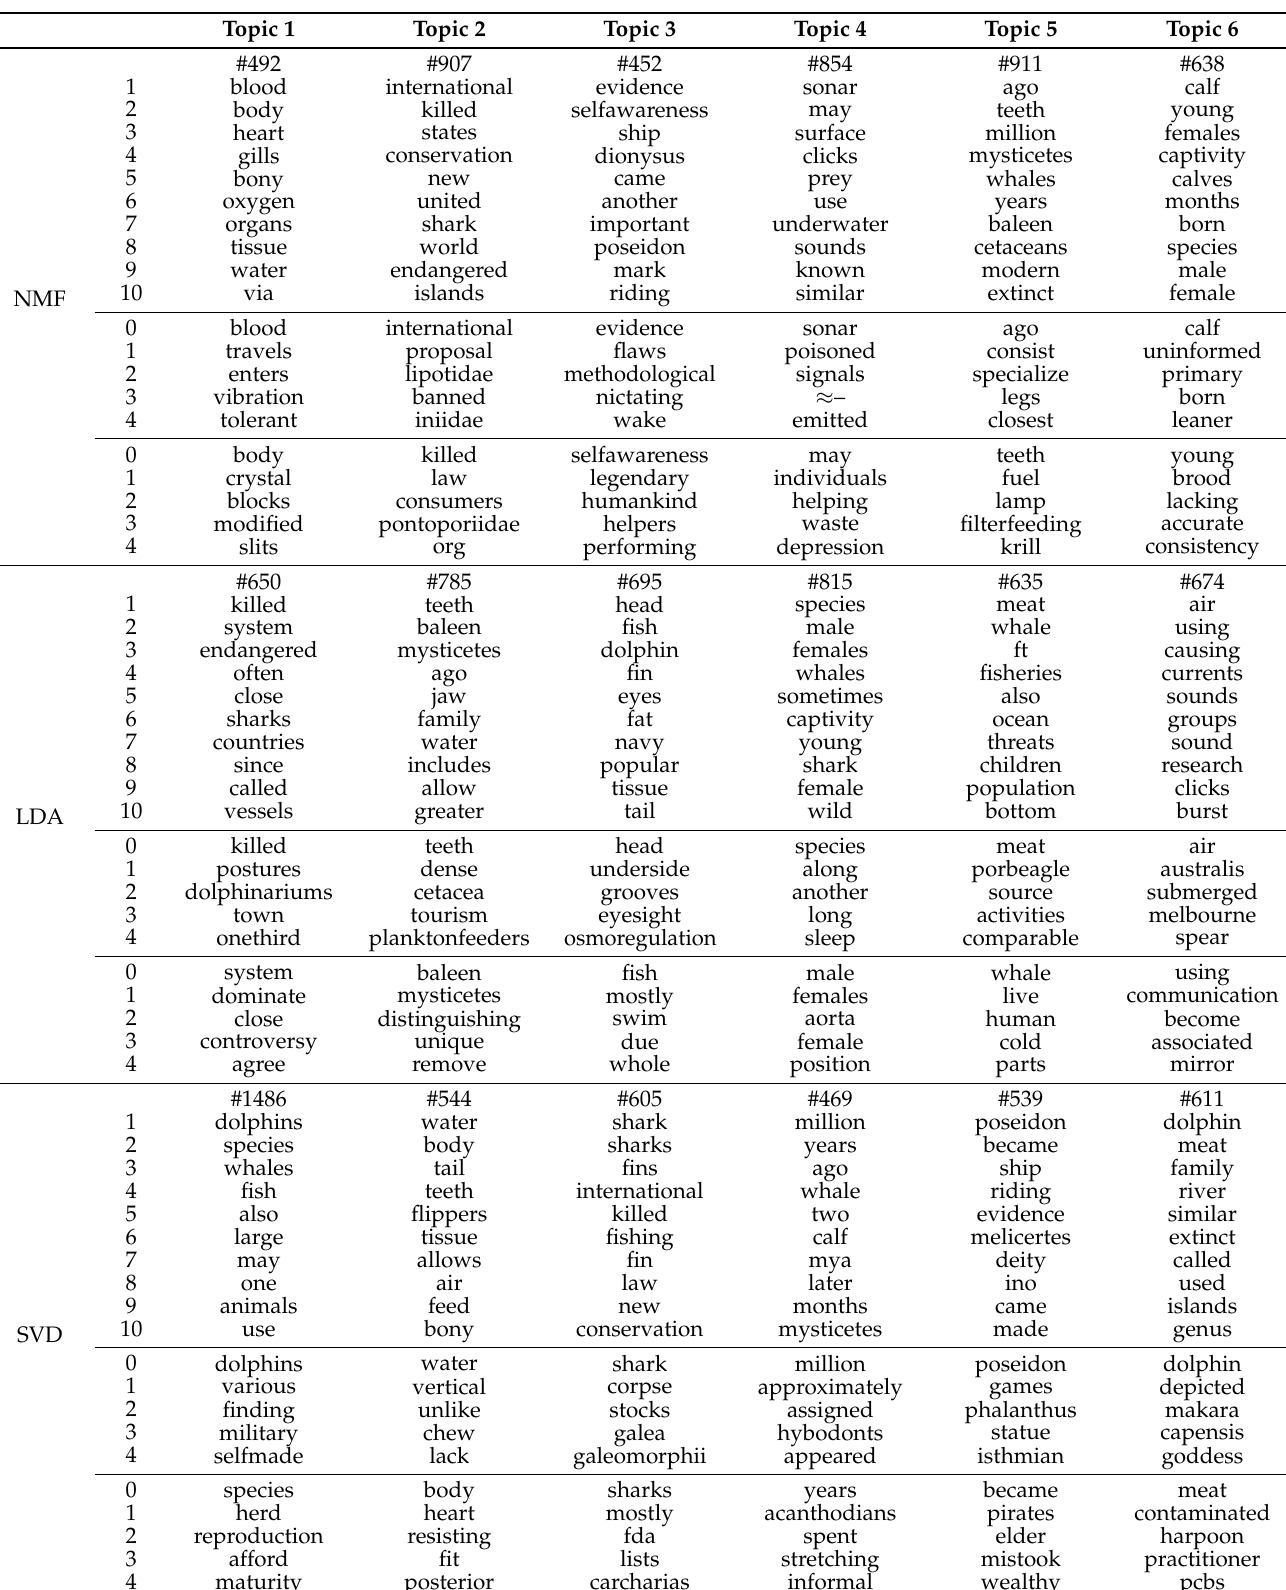
Table A3. For each evaluated matrix factorization method we display the top 10 words for each topic and the five most similar words based on cosine similarity for the two top words from each